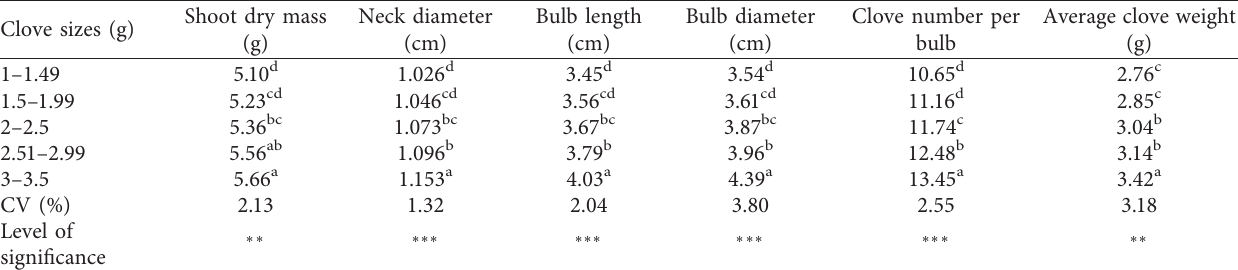
Table 3: Shoot dry mass, neck diameter, bulb length and diameter, clove number per bulb, and average clove weight of garlic as influenced by the effect of clove